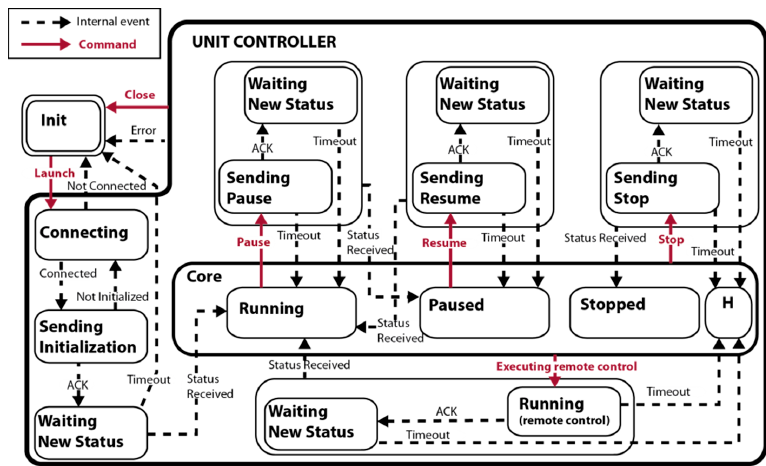
Figure 4. State diagram of the basic controller of a unit.